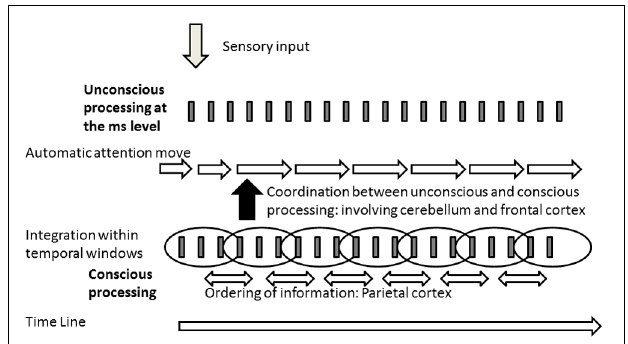
FIGURE 2 | Illustration of the model derived from the hypothesis of a dissociation between the processing of information at the unconscious and conscious levels. Information would be ordered only at the conscious level (involving the parietal cortex –Battelli et al., 2007; Davis et al., 2009; Binder, 2015), requiring a time coordination between the processing at the unconscious and conscious levels. Inasmuch this coordination would involve predictive mechanisms at the level of the ms, it points toward an interaction between cerebellum and the frontal cortex (Andreasen, 1999; Giersch et al.,